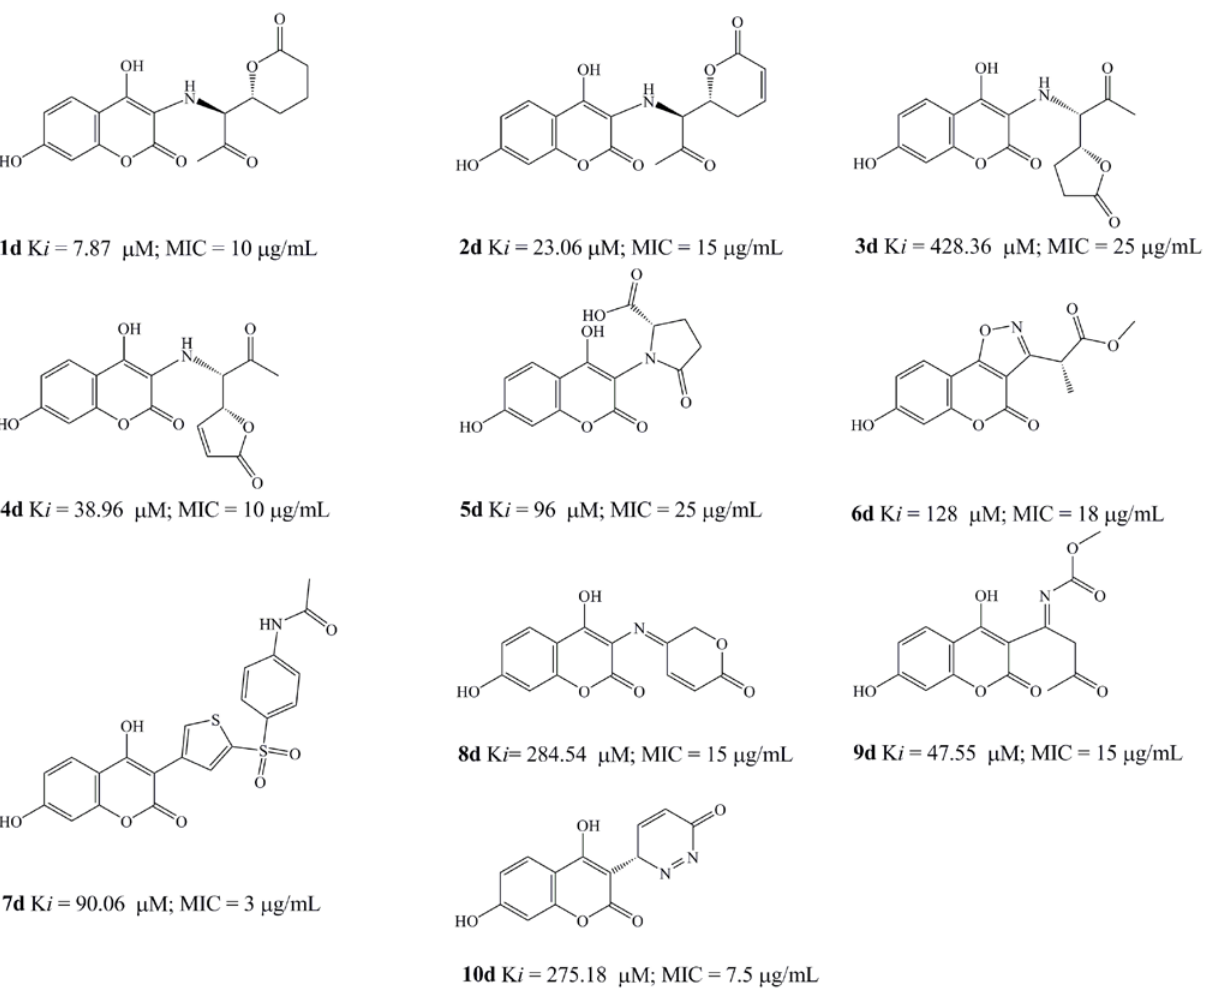
Figure 5. Designed 4-hydroxycoumarin